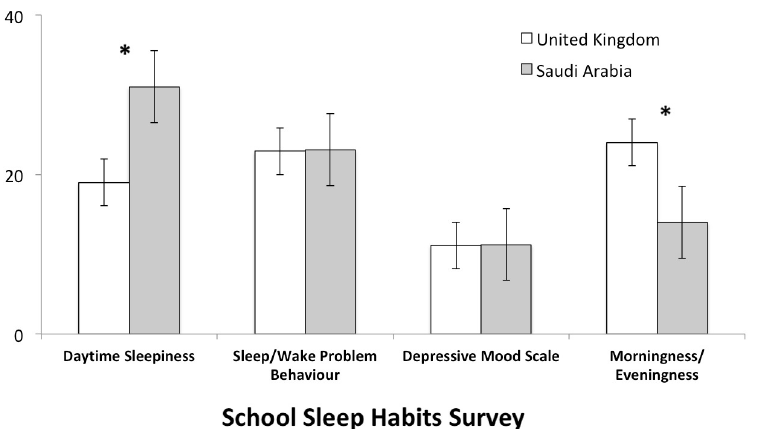
Figure 1. Mean percentage scores on the SSHS subscales. Daytime Sleepiness Scale: higher scores indicate daytime sleepiness; Sleep/Wake Problem Behaviour Scale: higher scores indicate greater problem behaviour. Morningness/Eveningness (M/E) Scale: lower scores indicate more eveningness and higher scores indicate more morningness. Depressive Mood Scale: higher scores indicate greater acute symptoms of depressed mood. * indicates a significant difference between the UK and Saudi Arabia